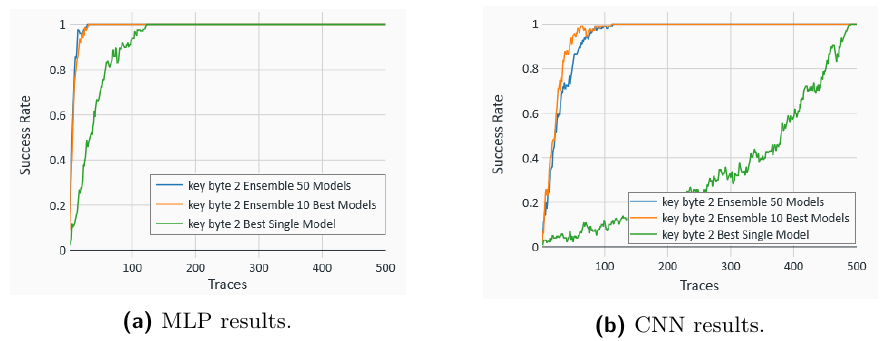
Figure 13: Success rate for ASCAD for the identity leakage